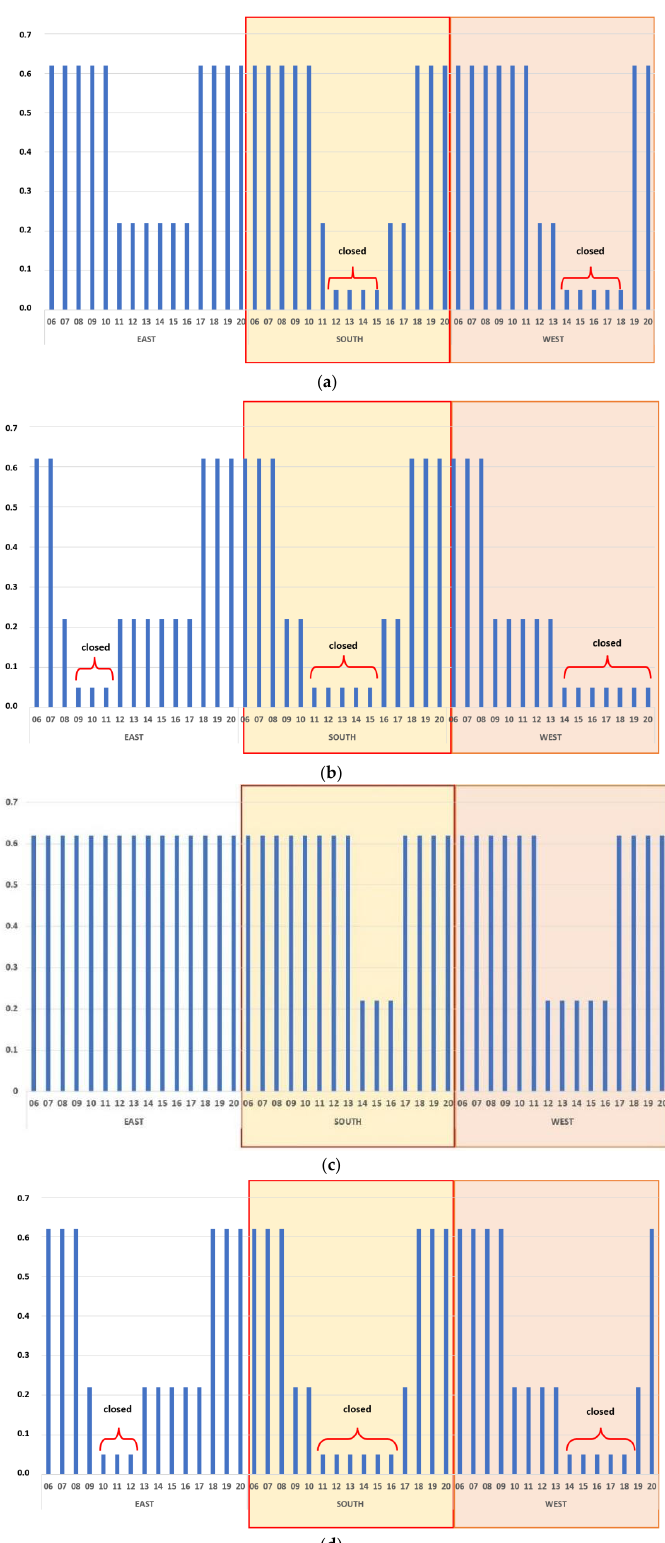
Figure 6. Operating times of the shielding flaps according to façade orientation, daytime and period of the year. Axis x = daytime, axis y = reduction/shielding factor F sh . ( a ) spring and autumn equinox, ( b ) summer solstice, ( c ) the hottest day of the year and ( d ) winter